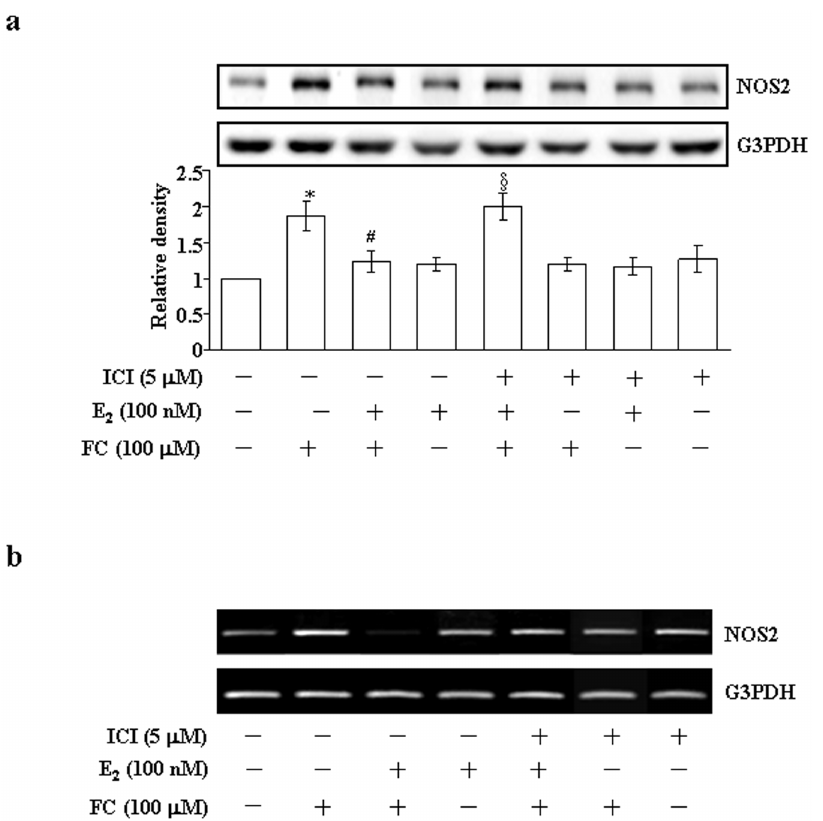
Figure 2. Effects of E2 on the FC-induced increases of the levels of NOS2 mRNA and protein in the CEC. The FC-induced increases of the levels of NOS2 protein (a) at 24 h after FC treatment and mRNA (b) at 16 h after FC (100 m M) treatment in the CEC were abolished by E2 (100 nM) treatment. This effect was blocked by pre-treatment of the cell with an ER antagonist, ICI (5 m M). Quantitative results of NOS2 protein levels, which were adjusted with G3PDH protein level and expressed as fold-induction of its own control. Values represent the means 6 s.e.mean. (n=4). * P , 0.05 different from control group. # P , 0.05 different from FC-treated group. 1 P , 0.05 different from combined treatment with FC and E2 group. E2, estradiol; FC, ferrous citrate; ICI, ICI